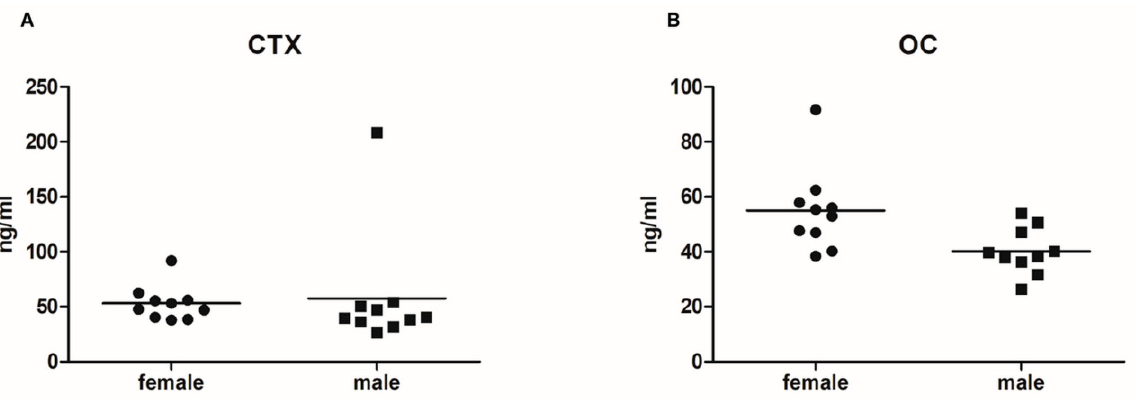
Figure 1. Data points of serum levels of ( A ) C-terminal telopeptide of type I procollagen (CTX) and ( B ) osteocalcin (Oc).